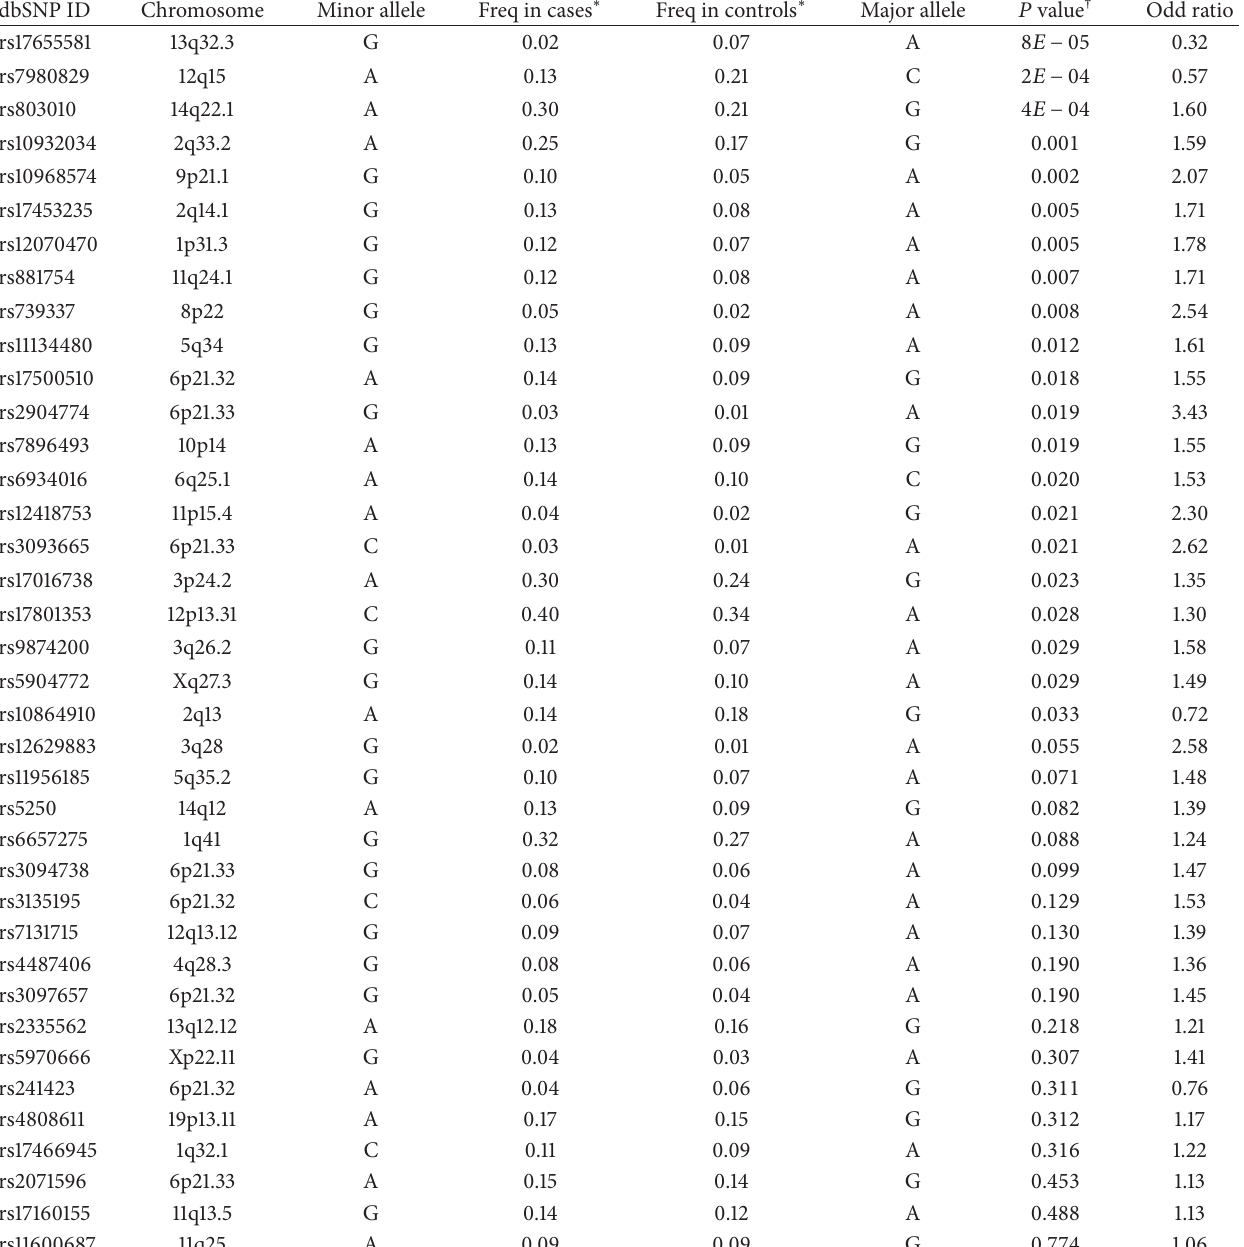
Table 4: Genetic association results for 38 SNPs tested by individual genotyping in 349 cases and 261